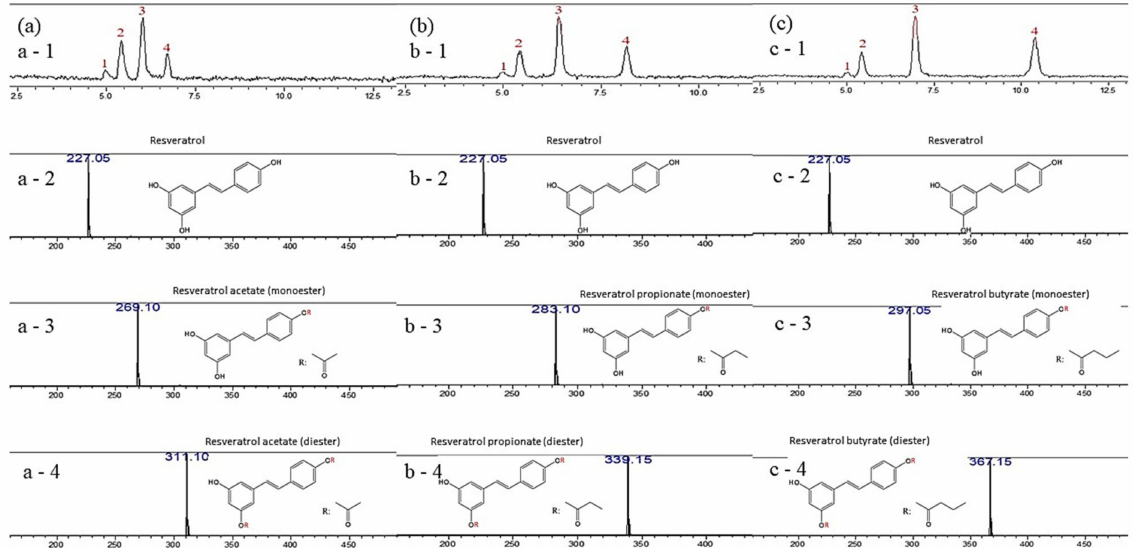
Figure 3. Liquid chromatography profiles of the products of the esterification of resveratrol with ( a ) acetic, ( b ) propionic, and ( c ) butyric acid. a-1, b-1, and b-3 represent the liquid chromatography analysis results of RAE, RPE, and RBE, respectively; a-2, a-3, and a-4 represent the MS assay result of liquid chromatography peaks 2, 3, and 4 of RAE. b-2, b-3, and b-4 represent the MS assay result of liquid chromatography peaks 2, 3, and 4 of RPE. c-2, c-3, and c-4 represent the MS assay result of liquid chromatography peaks 2, 3, and 4 of